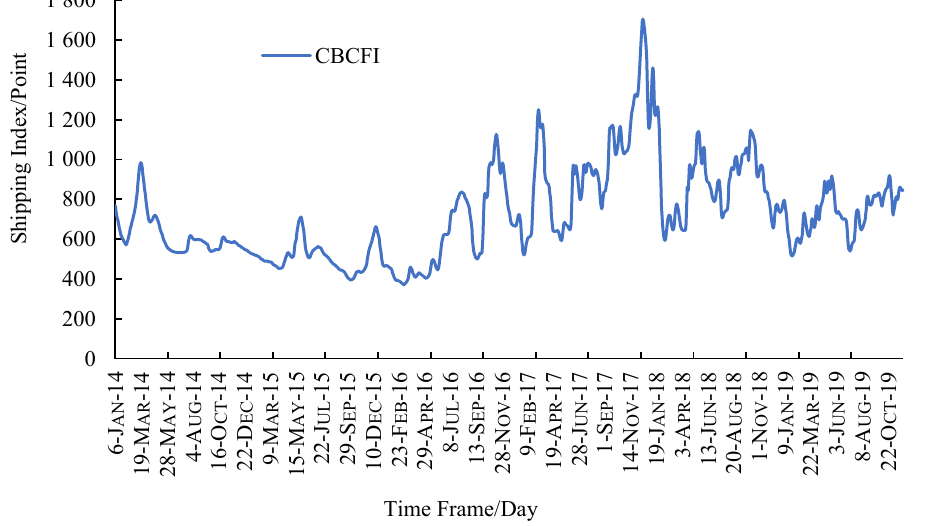
Figure 2. Historical data of CBFI.